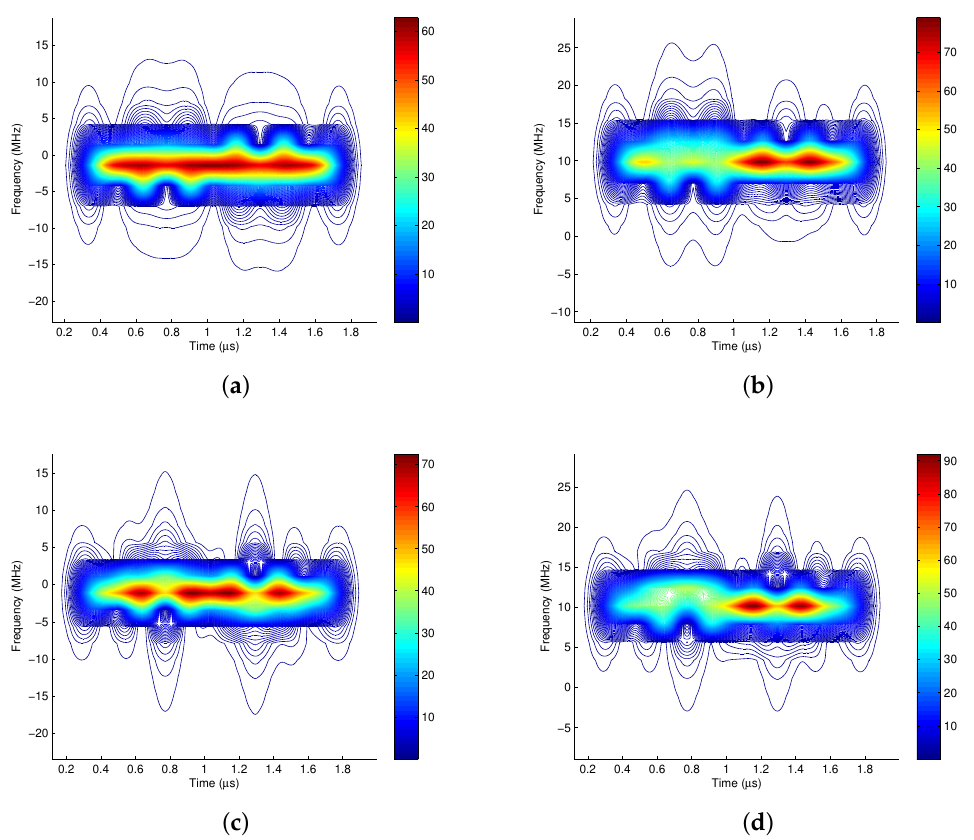
Figure 7. The effect of carrier leakage. ( a ) Baseband complex signal, L h = 40; ( b ) RF signal, L h = 40; ( c ) Baseband complex signal, L h = 50; ( d ) RF signal, L h =